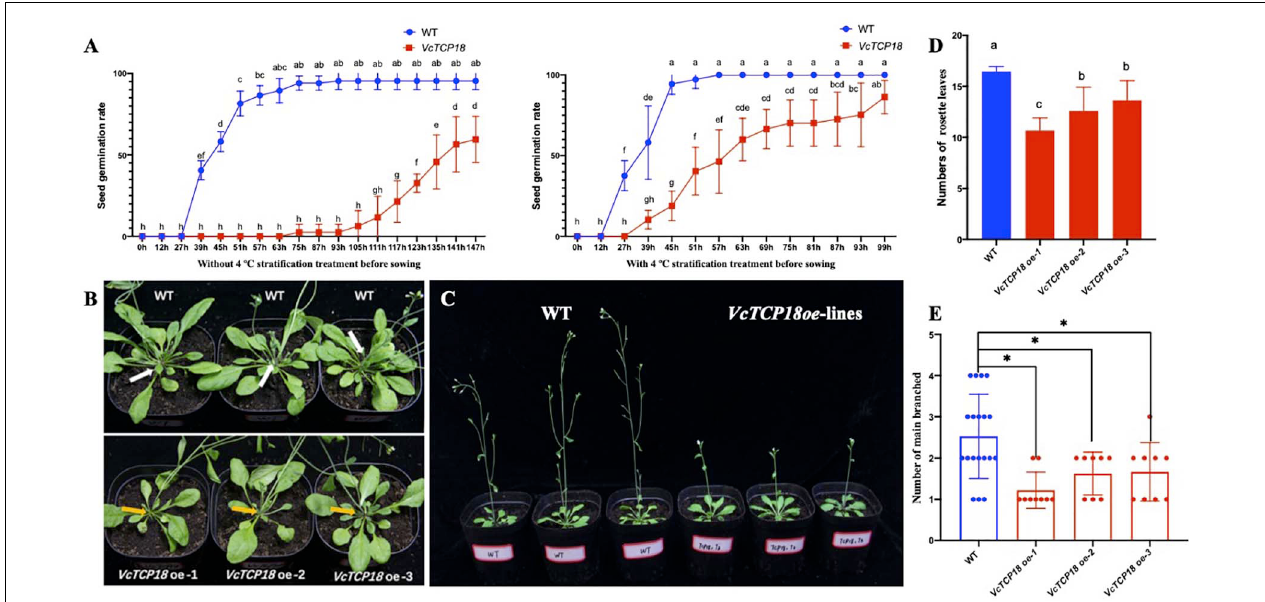
FIGURE 9 | Phenotypes of transgenic Arabidopsis with overexpression of VcTCP18 . (A) The seed germination rate of WT and transgenic lines with and without 4 ◦ C stratification treatment before sowing. (B) 30-day-old seedling observation of main branches, white and yellow arrows indicate main branches of WT and transgenic lines, respectively. (C) Flowering time observation, three lines on left are WT, the others on right are VcTCP18 -overexpressed transgenic lines. (D) At first flowering time, the numbers of rosette leaves, different letters indicate significant differences between WT and transgenic lines ( p < 0.05 ), statistical analysis was performed by one-way ANOVA followed by the Duncan test. (E) statistical analysis of the number of main branches in Transgenic plants and WT, each dot represents one plant. Asterisks ( ∗ ) indicate significant differences ( P < 0.05 ) based on Duncan